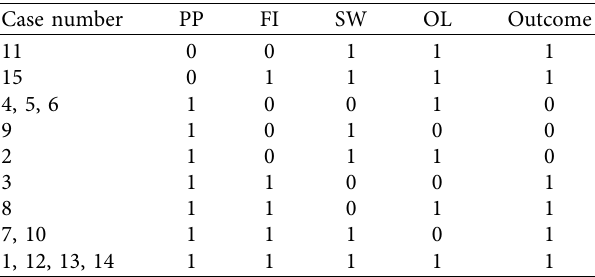
Table 7: Data matrix of each condition and damaged level. Table 8: Truth table of conditions and